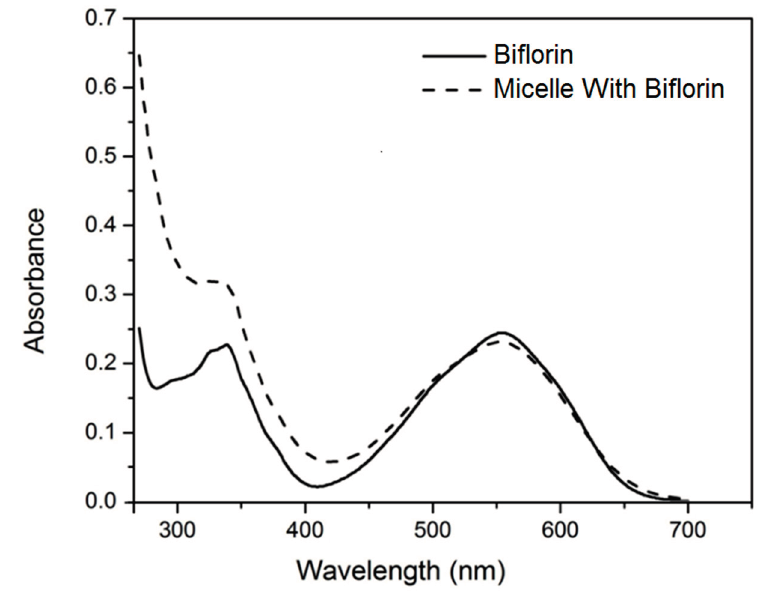
Figure 1. Absorption spectra of biflorin in ethanol (solid line) and biflorin micellar nanostructures (dashed